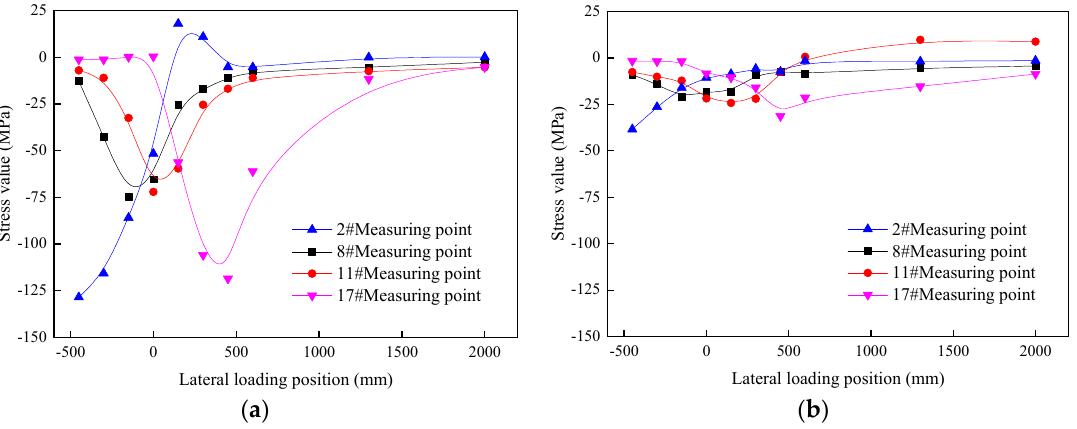
Figure 17. Transverse loading 100# diaphragm (steel reinforcement) CI area measuring point stress-load position relationship curve: ( a ) Before reinforcement, ( b ) after reinforcement. ③ The stress curve at the curved notch of the 105# cross-sectional plate reinforced